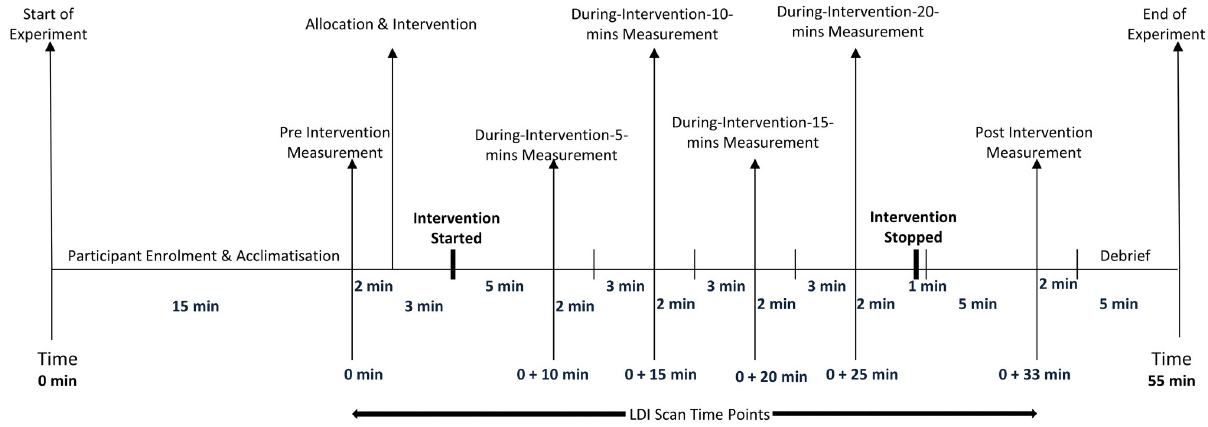
Fig 3. Sequence of events of the experimental procedure and laser Doppler imaging scan time